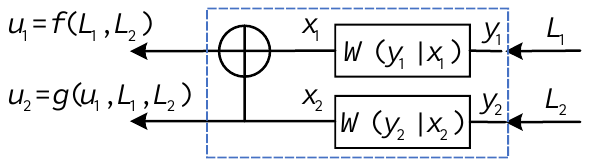
Figure 1. Basic unit model of a polar code.